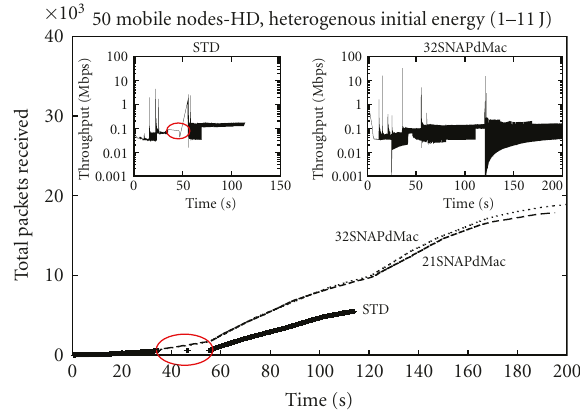
Figure 14: General results of HD/C scenario (2)—heterogeneous